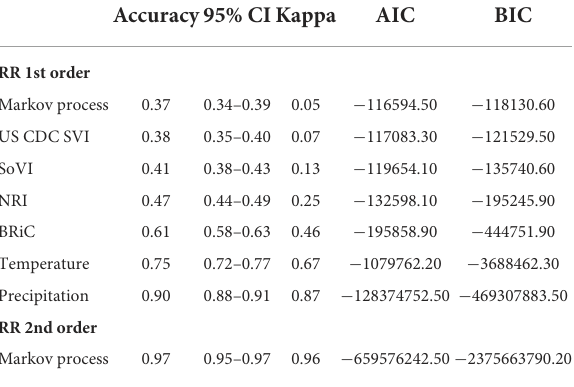
TABLE 3 Incremental addition of variables into the DBN.